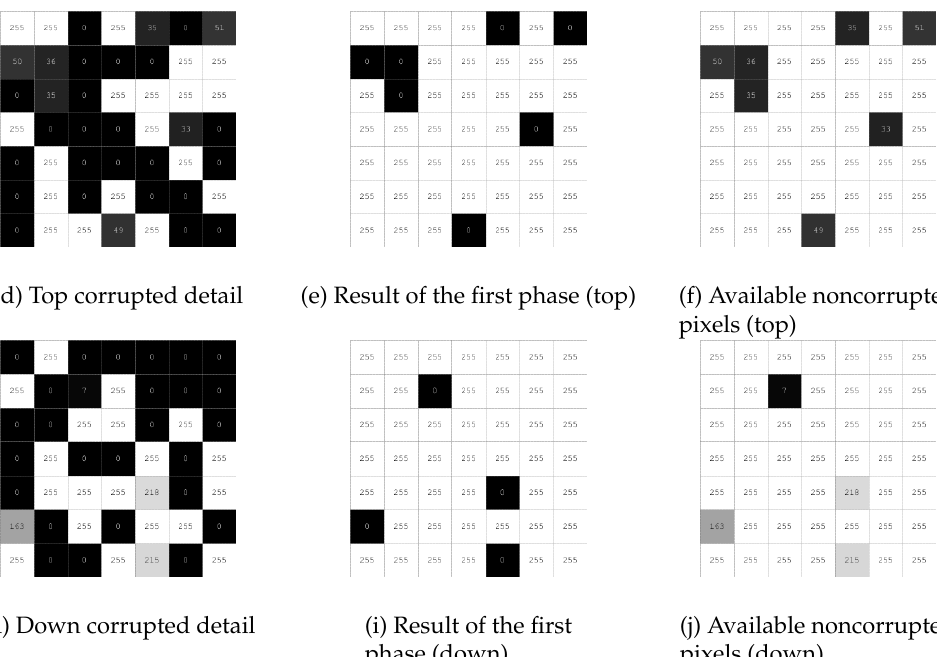
Figure 1. Two graphical examples of the result of the function described in the noise detection stage introduced in Section 3.1 and the available noncorrupted